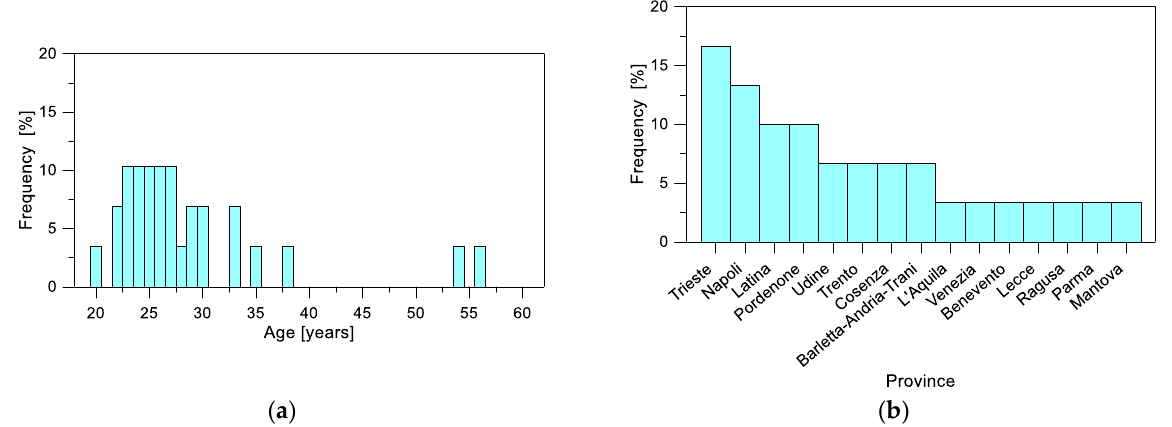
Figure 4. ( a ) Age demographics and ( b ) geographic distribution of